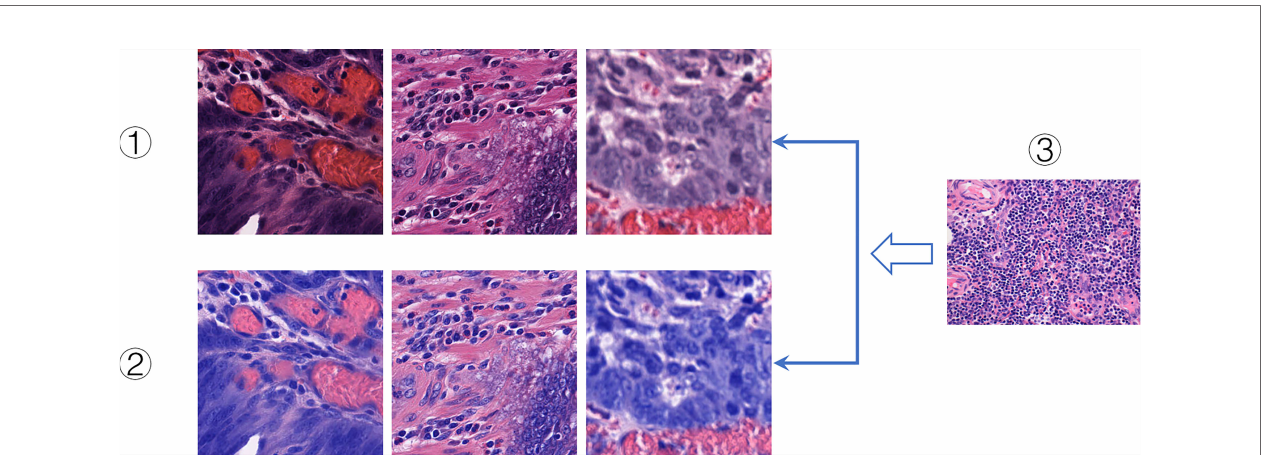
FIGURE 5 | Color normalization. I. Original slice images. II. Color-normalized slice images. III. Reference